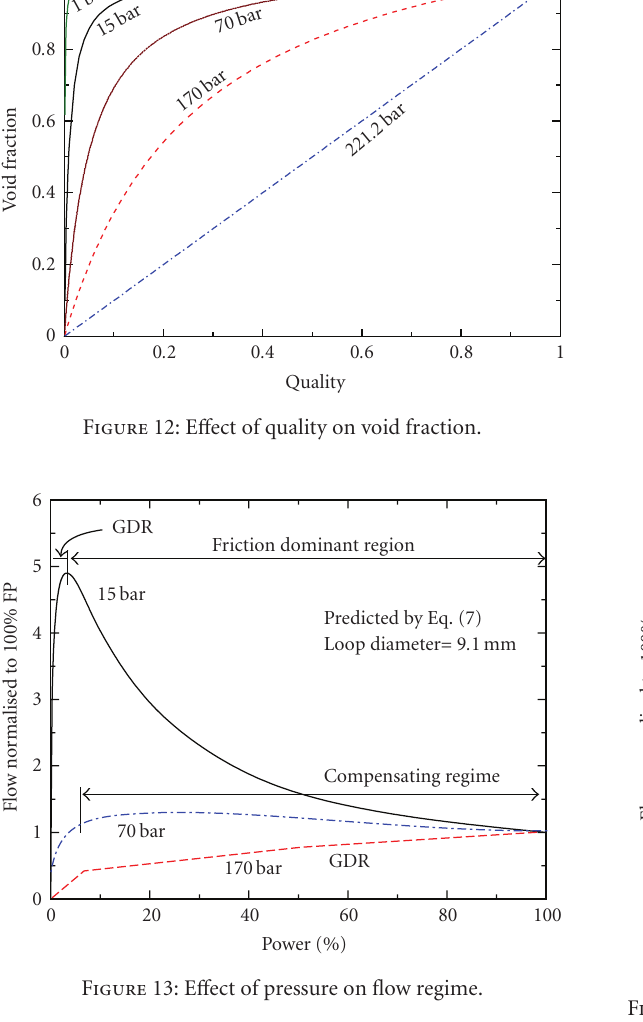
Figure 14: E ff ect of pressure on flow regime for di ff erent loop